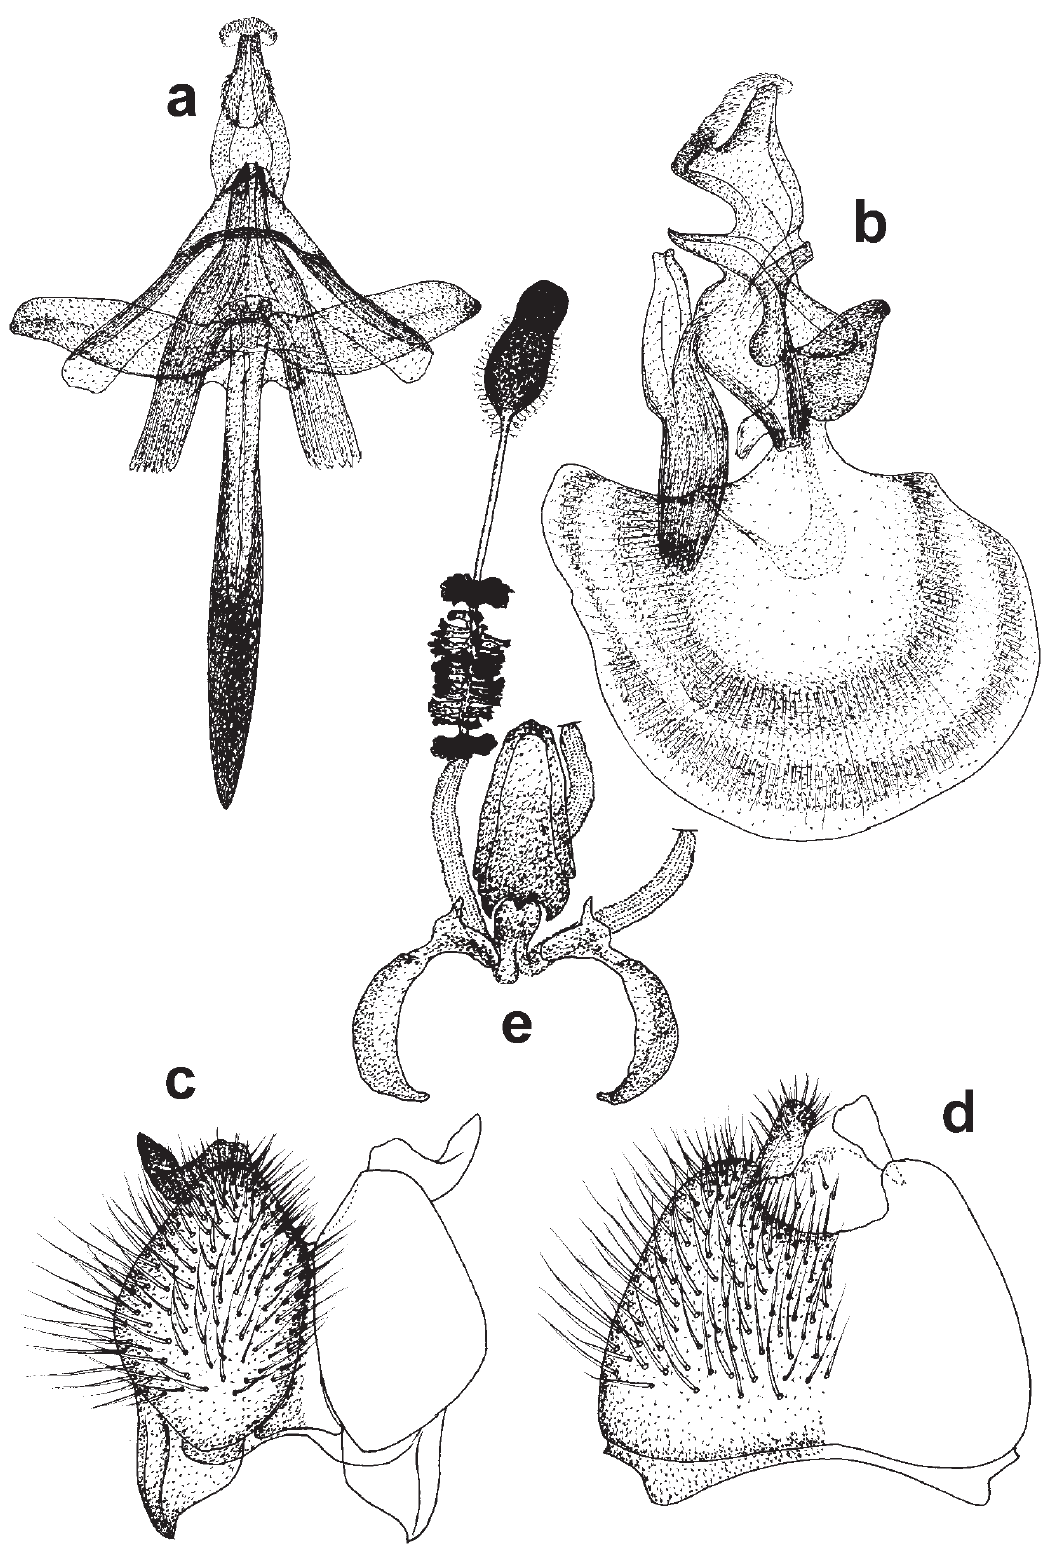
Fig. 67. Parusia taeniolata (Costa, 1883) stat. rev., gen. et comb. nov. a . Epiphallic complex ventral. b . Epiphallic complex lateral. c . Gonocoxite ventral. d . Epandrium dorsal. e . Female genitalia